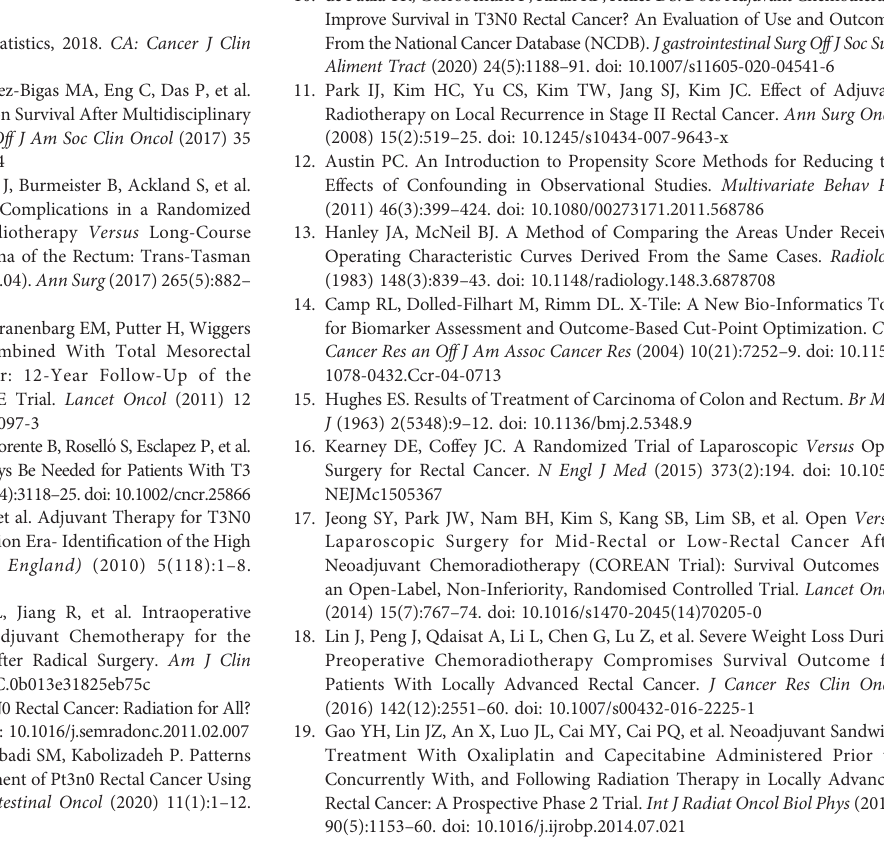
Supplementary Figure 1 | The Kaplan-Meier curves of OS for patients in external validationgroup. (A) Allpatients; (B) OSindifferentrisksubgroupsofallpatients; (C) OS in differentrisk subgroups of non-ATgroup; (D) OS in different risk subgroups of ATgroup; (E) OSforpatientswithorwithoutATinlowriskgroup; (F) OSforpatients with or without AT in moderate risk group; (G) OS for patients with or without AT in high risk